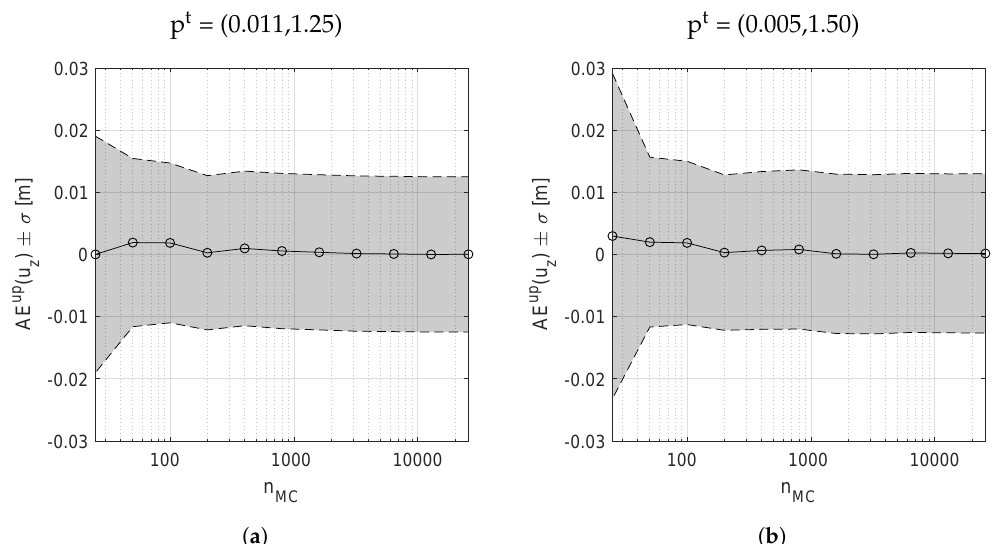
Figure 9. Mean and standard deviation for the updated displacements on the observation point varying the size of the